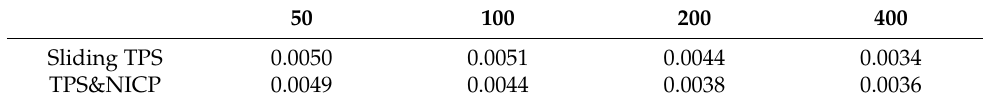
Table 5. Procrustes distances between the vertices of mean ape cranial surfaces estimated by each approach using 800 semilandmarks and those estimated using increasing numbers of semilandmarks after re-semilandmarking and re-warping the template mesh.